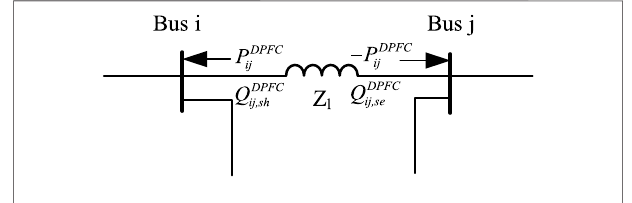
FIGURE 2 | PIM model of the